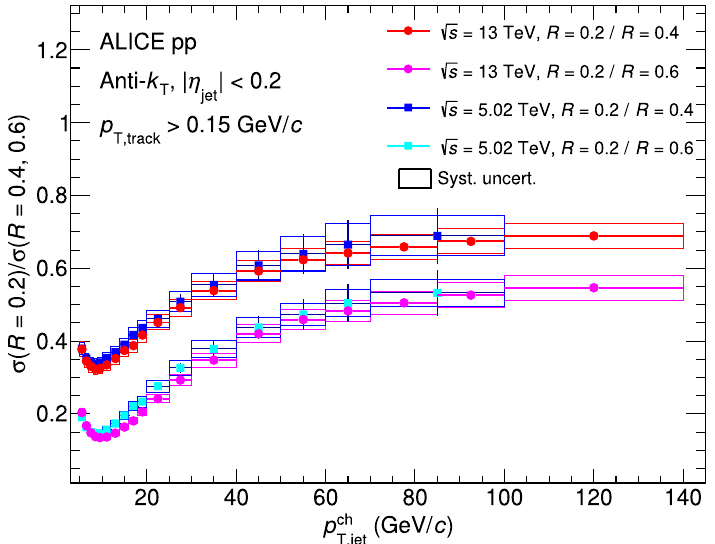
Fig. 18 Comparison of charged-particle jet cross section ratios for σ( R = 0 . 2 )/σ( R = 0 . 4 ) and σ( R = 0 . 2 )/σ( R = 0 . 6 ) without UE subtraction √ s = 13 and 5 . 02 TeV [12] in pp collisions at